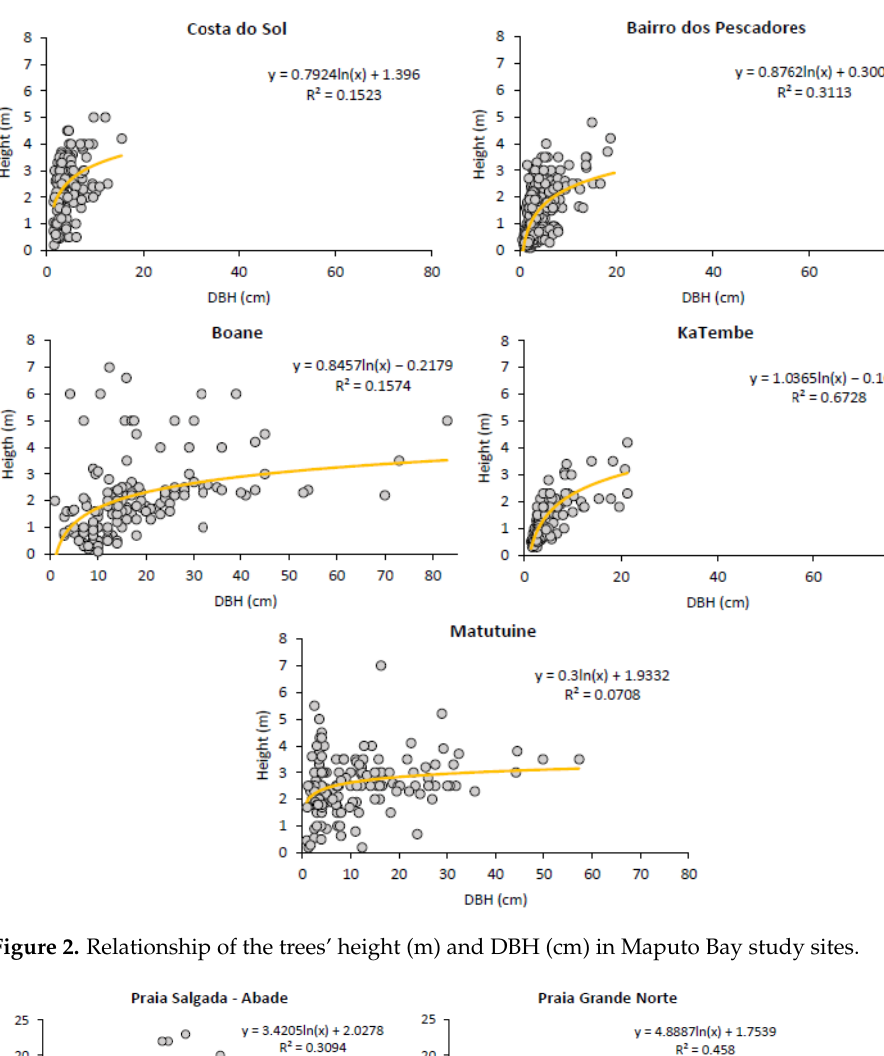
Figure 2. Relationship of the trees’ height (m) and DBH (cm) in Maputo Bay study sites. The mangroves on Príncipe Island have mainly adult trees with the minimum means for DBH and height registered at Praia Grande Norte and the maximum DBH and height means registered at Praia Caixão (Table 4). Praia Salgada and Praia Grande Norte showed similar tree mean heights. Both DBH and Height showed statistically significant differ- ence (Kruskal – Wallis; H = 53.308; DF = 2; N = 262; p < 0.05) and (Kruskal – Wallis; H = 25.879; DF = 2; N = 227; p < 0.05), respectively. On Príncipe Island, the mangrove trees are mainly adults, with mean DBHs of 10.22±0.42 cm and heights of 9.80 ± 0.29 m. The relationship between DBH and the height of the trees on Príncipe Island (Figure 3) showed that Praia Grande presented the lowest DBH (Figure 3). Table 4. Mangrove structural parameters at the different locations on Príncipe Island.